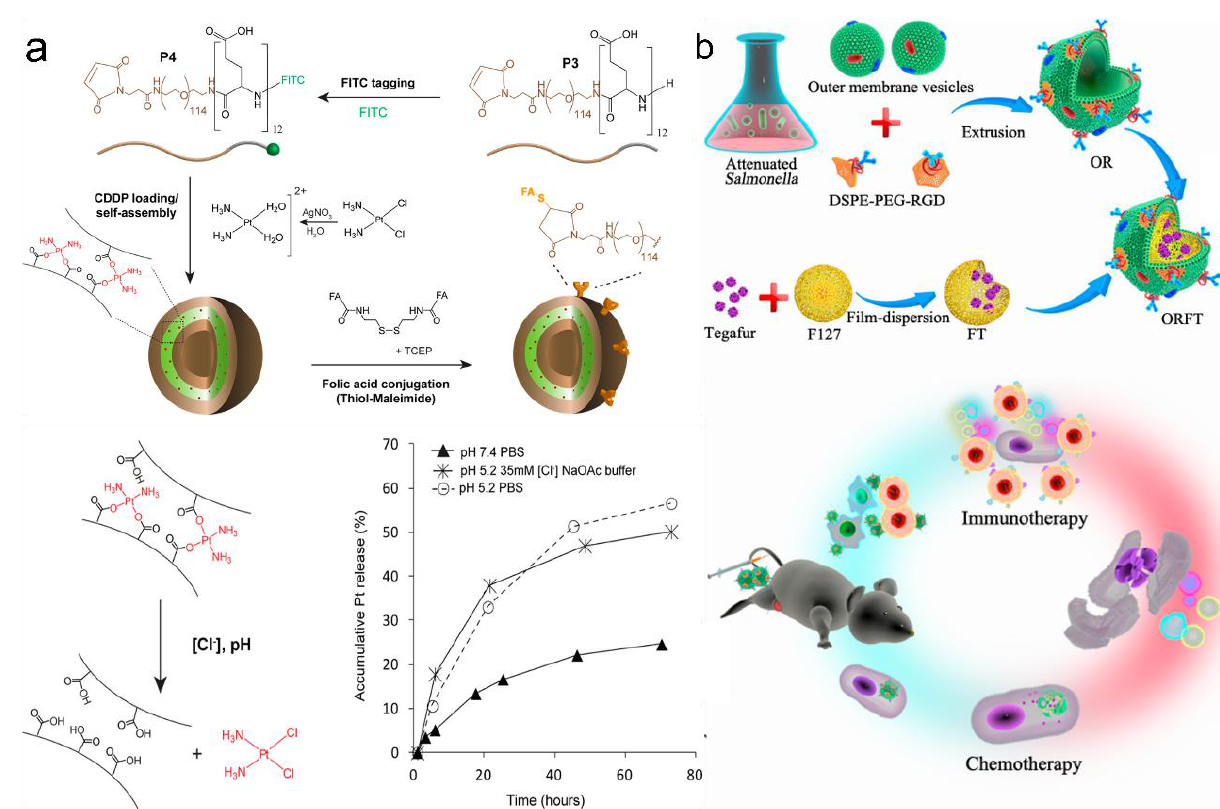
Figure 7. Targeted drug delivery via PVs and OMVs. ( a ) Drug release ability of cisplatin complexed with the PEG-b-PLG. Reprinted with permission from Ref. [103]. Copyright: 2015, American Chemical Society. ( b ) Schematic diagram of bioengineered OMV-coated polymeric nanomedicine. Reprinted with permission from Ref. [83]. Copyright: 2020, American Chemical Society.